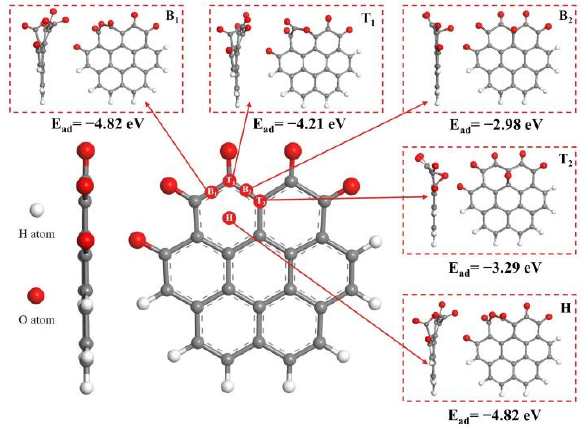
Figure 3. Adsorption energy and structure change of O atom adsorbed on Model A. The preferential adsorption sites of the O atom were analyzed from the perspective of electronic structure. The density of states of the O atom adsorbed at different sites on the surface of Model A and the projected density of states of the O atom before adsorption were calculated, as shown in Figure 4. Both 2s and 2p orbitals of oxygen shift toward lower energy levels after adsorption, which reduces the energy of the O atom, so the O atom after adsorption is more stable. By integrating the density of states curves of O atoms after adsorption on different sites and setting the upper limit at Fermi level (shown by the dashed vertically line in the figure), it is found that the integral value is the largest when the O atom is adsorbed at B 1 and H sites. This indicates that the number of electrons with energy lower than the Fermi level is largest when the O atom adsorbs at the B 1 and H sites, meaning these two structures are the most stable. While the energy of the O atom adsorp- tion at B 2 does not change much compared with that before adsorption, indicating that the configuration after adsorption is not stable. The results of the density of states are in ac- cordance with the adsorption energy calculation.